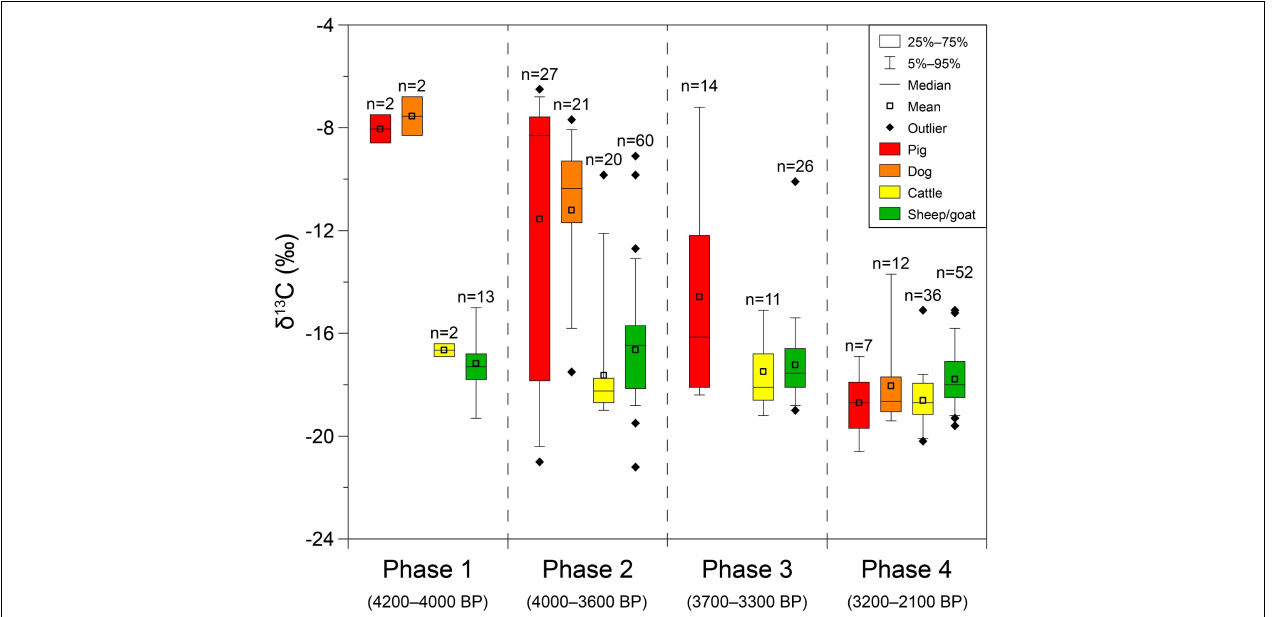
FIGURE 5 | Box plot of stable carbon isotope data of four major omnivorous and herbivorous livestock in prehistoric Hexi Corridor from published works (Atahan et al., 2011; Zhang et al., 2015; Yang, 2017; Yang et al., 2019b; Ma et al., 2021; Vaiglova et al., 2021) and this study ( Supplementary Table 1 ). Data are divided into four phases: (1) Machang Culture; (2) Xichengyi/Qijia Culture; (3) Siba Culture; and (4) Dongjiatai and Shanma/Shajing